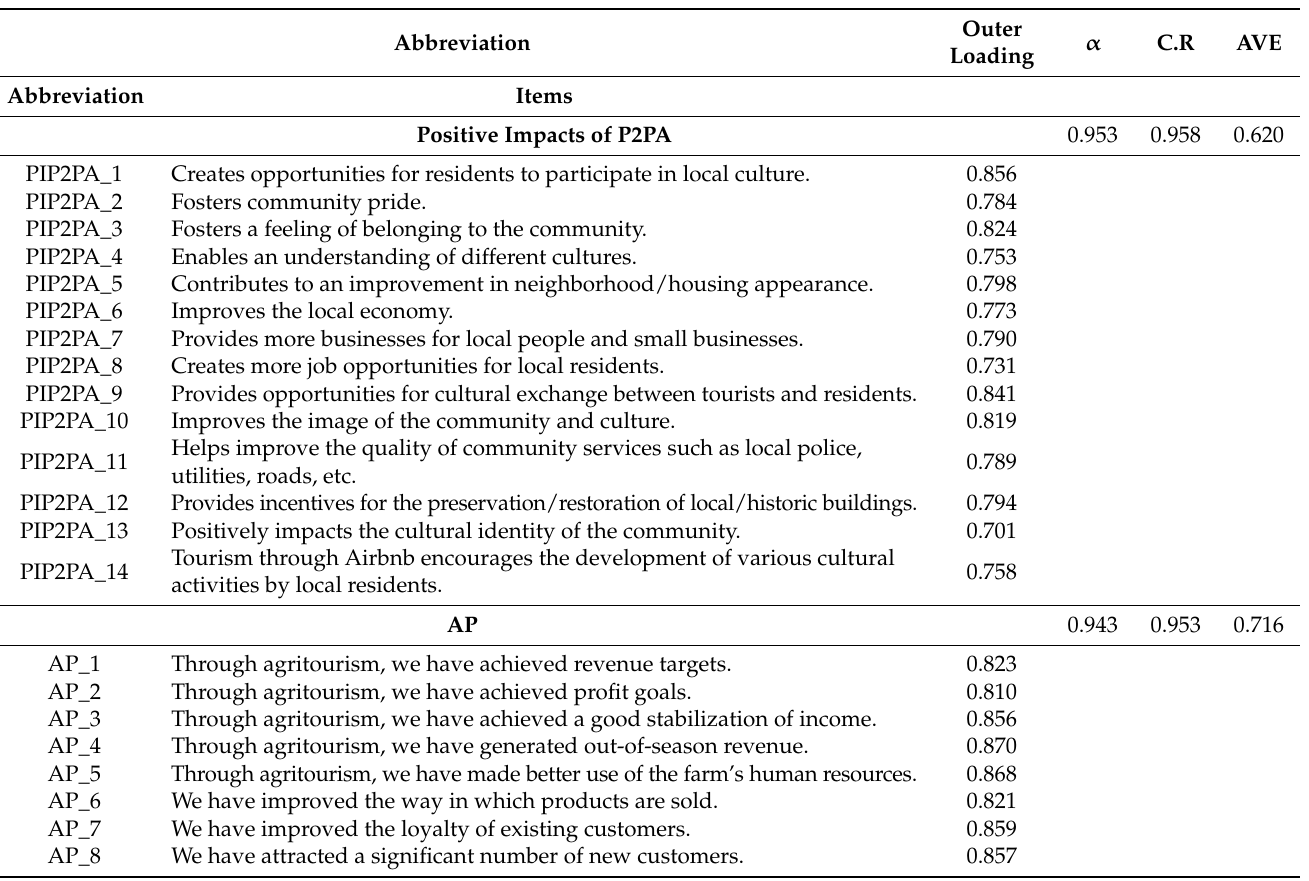
Table 1. Assessment of the formative measurement